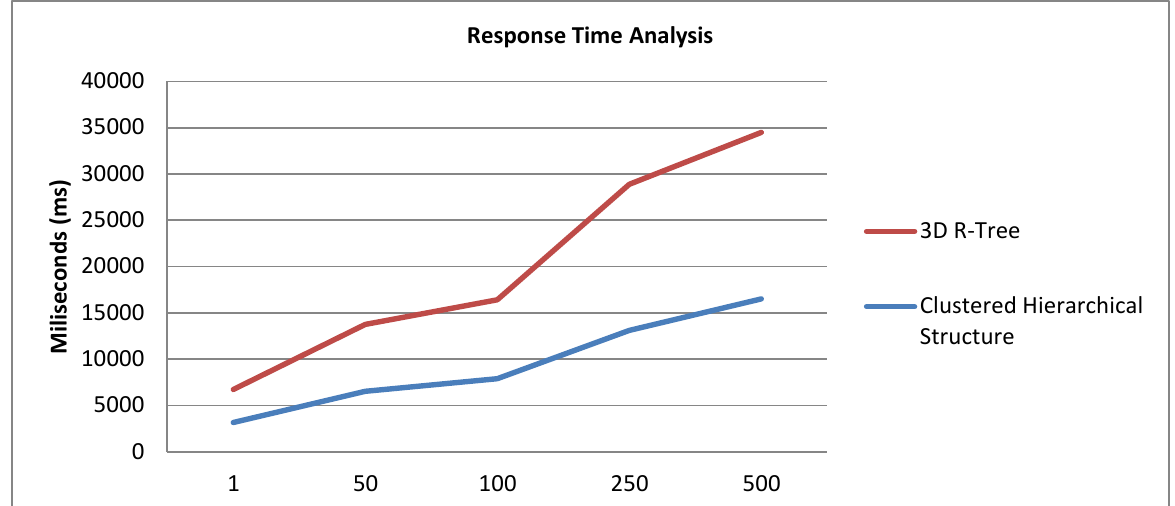
Figure 5. Response time analysis of nearest neighbor